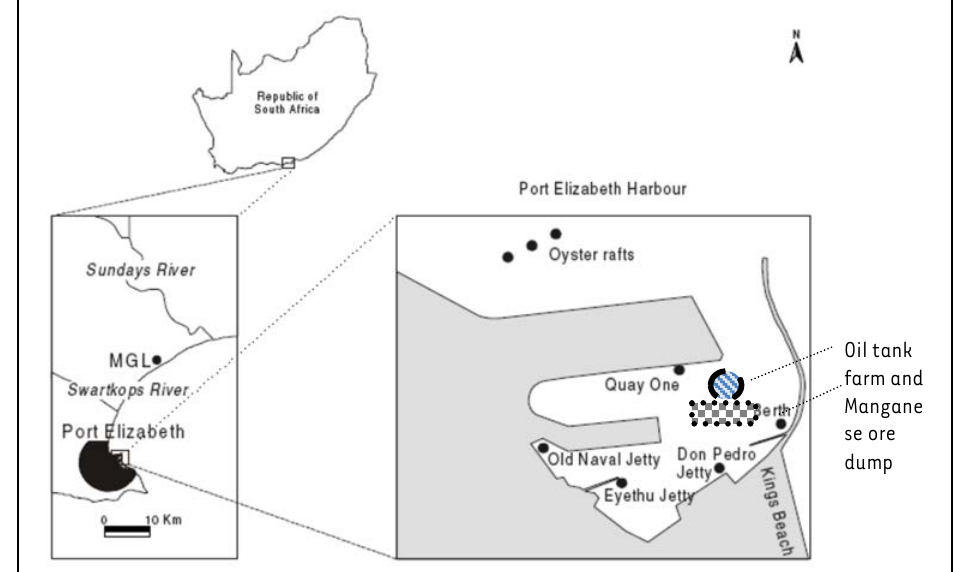
FIGURE 1: The location of the manganese ore dump and oil tank farm Source: Shackleton, Schoeman & Newman,